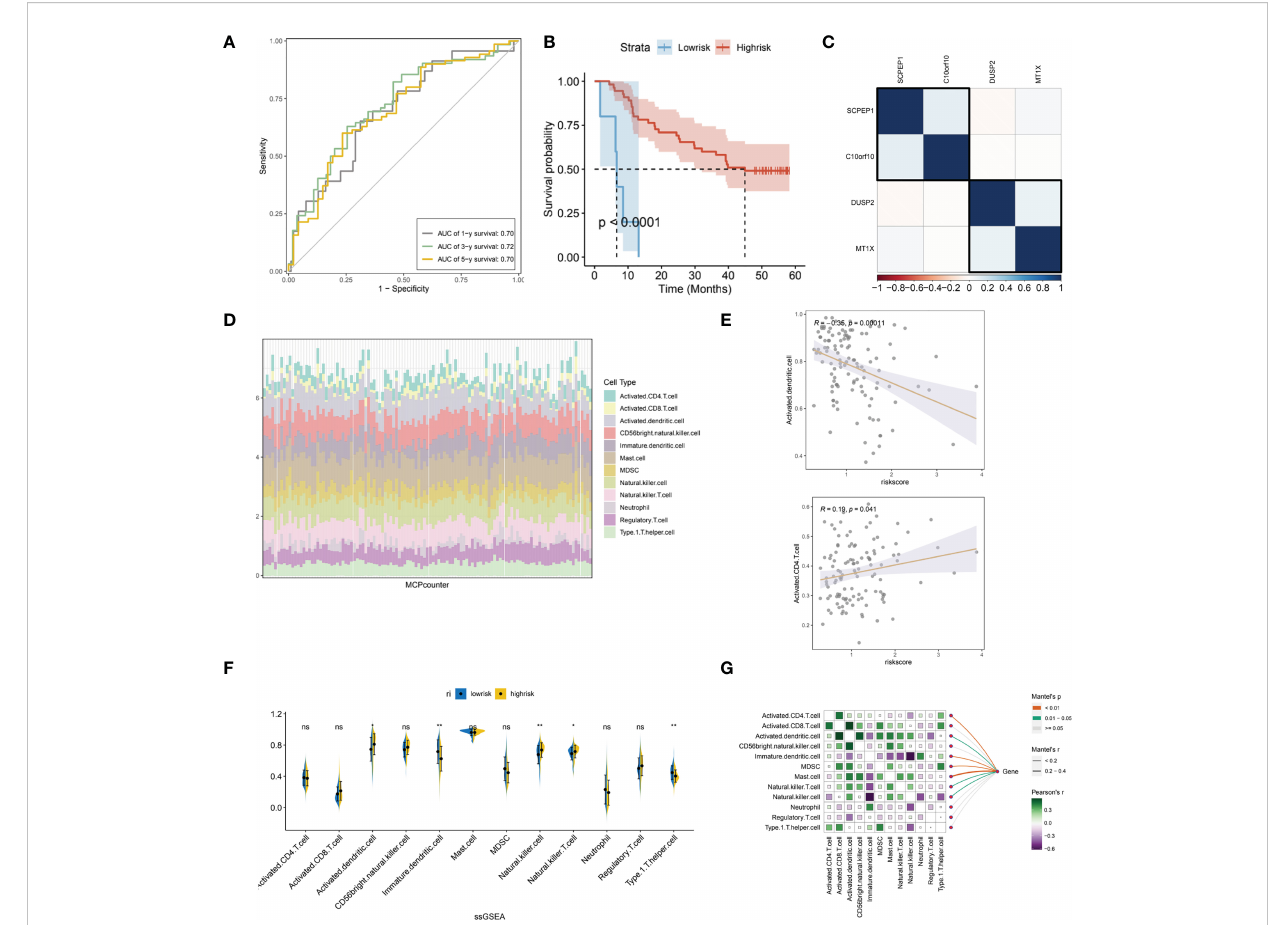
FIGURE 5 Independent validation of the lysosomal pathway-associated risk model and preliminary analysis of immune in fi ltration. (A) Prognostic prediction ROC curves for the lysosomal pathway-associated prognostic risk model ,with AUC values of 0.70, 0. 72 and 0.70 for 1-year, 3-year and 5-year, respectively; (B) Kaplan-Meier curves for the prognostic risk model in the GSE53622 independent validation cohort, p<0.0001. (C) Heat map revealing the expression correlation of the four lysosomal-DEGs that comprise the lysosomal pathway risk model, with SCPEP1 possessing a high expression correlation with C10orf10 and a signi fi cant association between DUSP2 and MT1X expression; (D) MCPcounter calculated histograms analyzing the potential immune cell constitutive types of risksocre; (E) in addition, we analysed the correlation between the expression of activated dendritic cells as well as activated CD4 T cells and risk scores; (F) ssGSEA analysis, revealing the enriched expression of immune cells and immune in fi ltration pathways between the low and high risk groups. Among them, the expression of Neutrophill, lmmature.dendritic and Th1 T cells was signi fi cantly higher in the low-risk group than in the high-risk group. In contrast, the expression of NK T cells as well as Activated.dendritic.cells was signi fi cantly higher in the high-risk group than in the low-risk group; (G) Heat map reveals the correlation between the expression of different immune cells and immune pathways using Pearson correlation. * means <0.05,** means <0.01, ns means